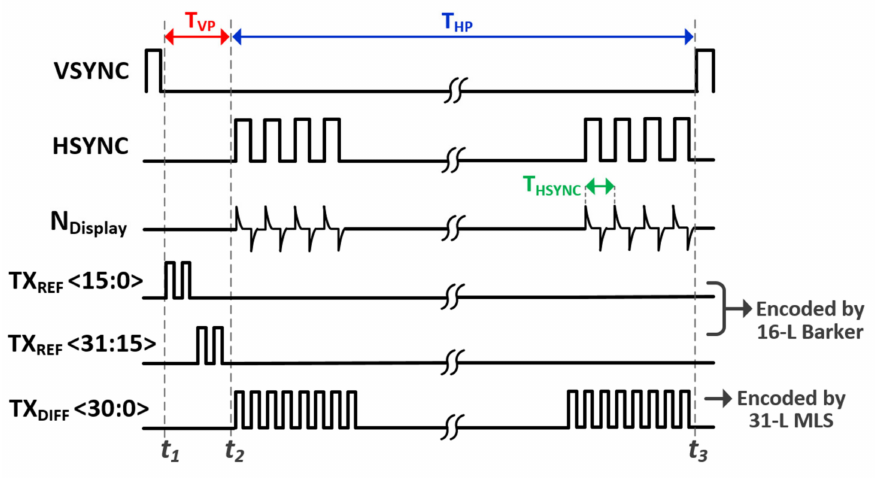
Figure 4. Timing diagram for illustrating the proposed differential TSP sensing